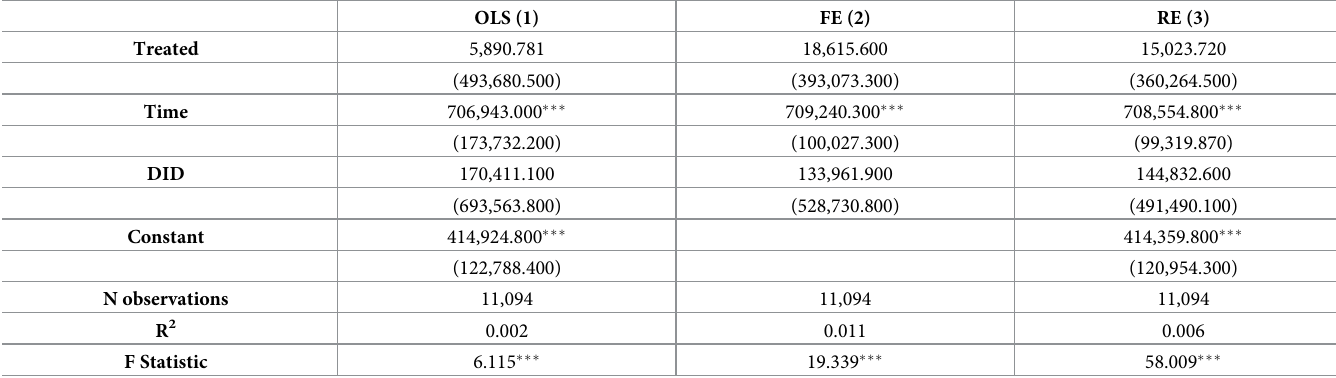
Table 9. Difference-in-differences with PSM weight GDP results: Pooling, fixed-effects, and random-effects .